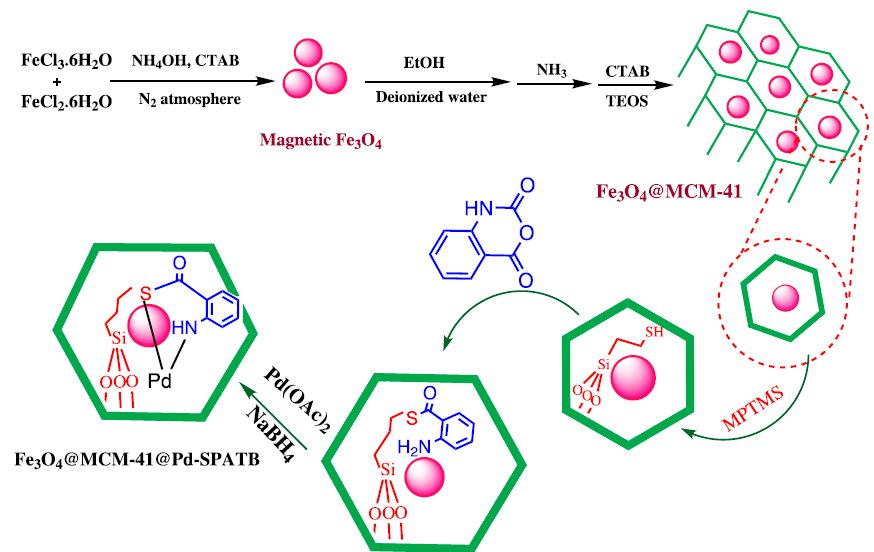
Figure 63. Synthesis of Fe 3 O 4 @MCM-41@Pd-SPATB. Reproduced with permission from [165].